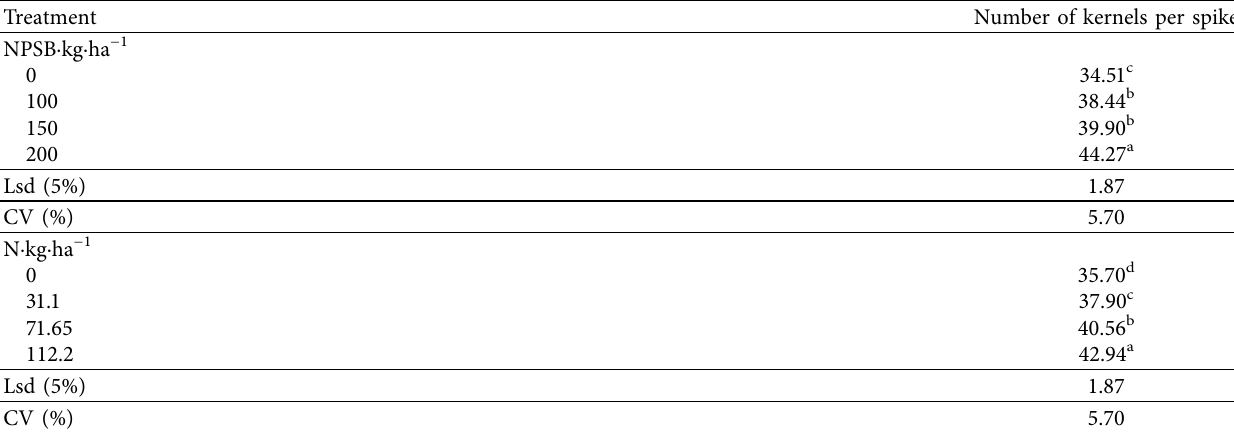
Table 5: The main determinants of the number of kernels per spike of bread wheat are NPSB and nitrogen fertilizer levels. Treatment